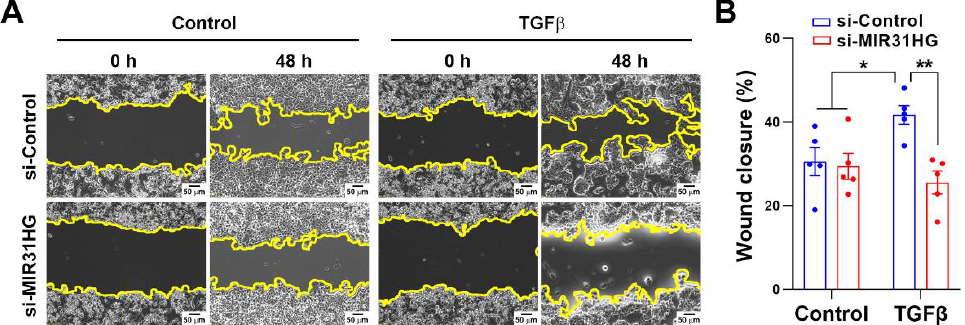
Figure 5. Knockdown of MIR31HG reversed transforming growth factor β ( TGFβ ) -induced cell migration: ( A ) PANC-1 cells were transfected with MIR31HG or control siRNA for 24 h and then a wound was created and photographed before (0 h) and after treatment with 5 ng/mL TGFβ for 48 h. Cell migration was examined by the wound closure rate. S cale bar, 50 μm; (B) Results in (a) were quantified (mean ± standard error of the mean, SEM). * p <0.05 and ** p <0.01 indicate statisti- quantified (mean ± standard error of the mean, SEM). * p < 0.05 and ** p < 0.01 indicate statistical cal significance between groups. significance between